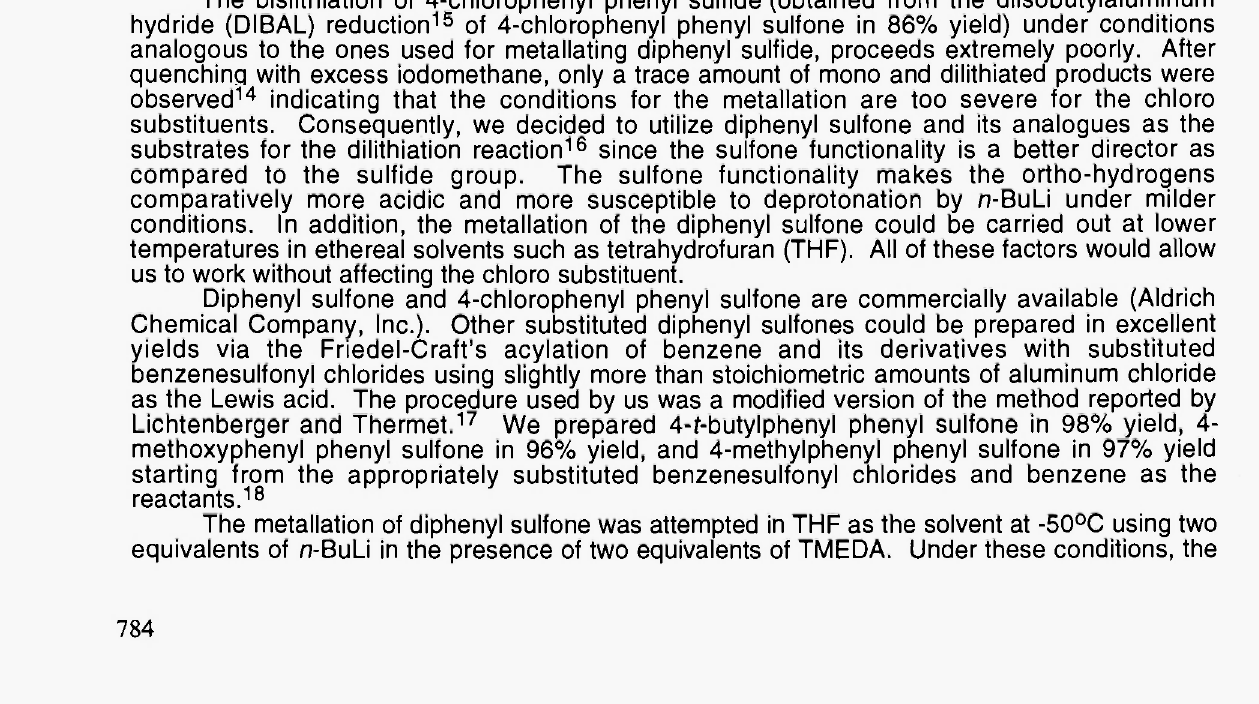
Table 1. Dilithiation conditions for diaryl substrates using 2eq n-BuLi / 2eq TMEDA.